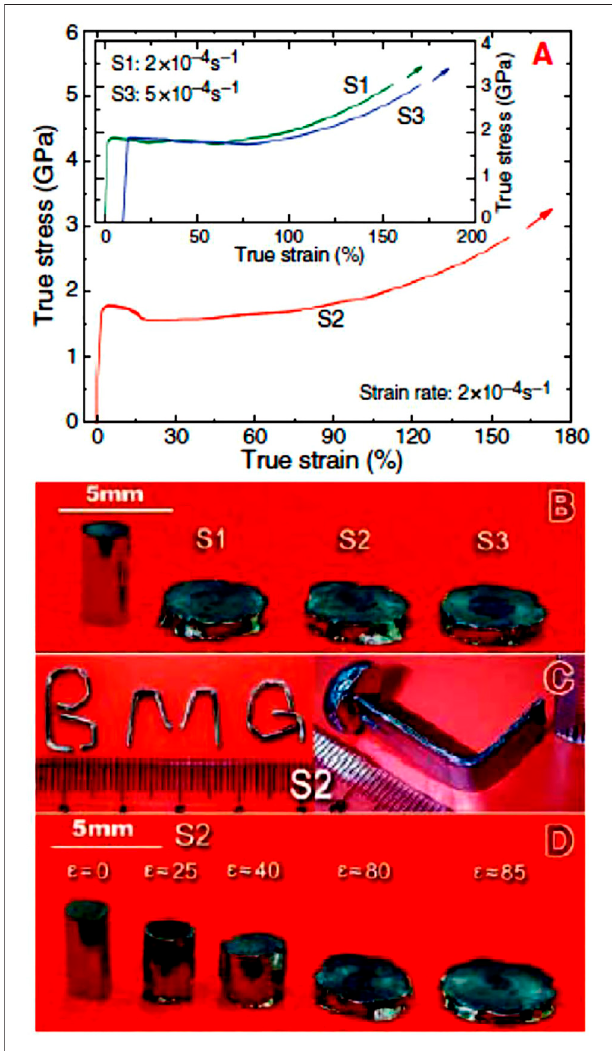
FIGURE 2 | Demonstration of the deformation of the ZrCuNiAl BMG by the compression and bending experiments. (A) True stress-true strain curve of S1 (Zr 61.88 Cu 18 Ni 10.12 Al 10 ), S2 (Zr 64.13 Cu 15.75 Ni 10.12 Al 10 ), and S3 (Zr 62 Cu 15.5 Ni 12.5 Al 10 ) is tested at room temperature. (B) Deformed (under compression) fl akes ’ images of S1, S2, and S3. (C) Demonstration of exceptional deformability of S2 through bending into different shapes. (D) S2 BMG deformed at various compressive strains. Adapted from Figure 2 of Liu et al.